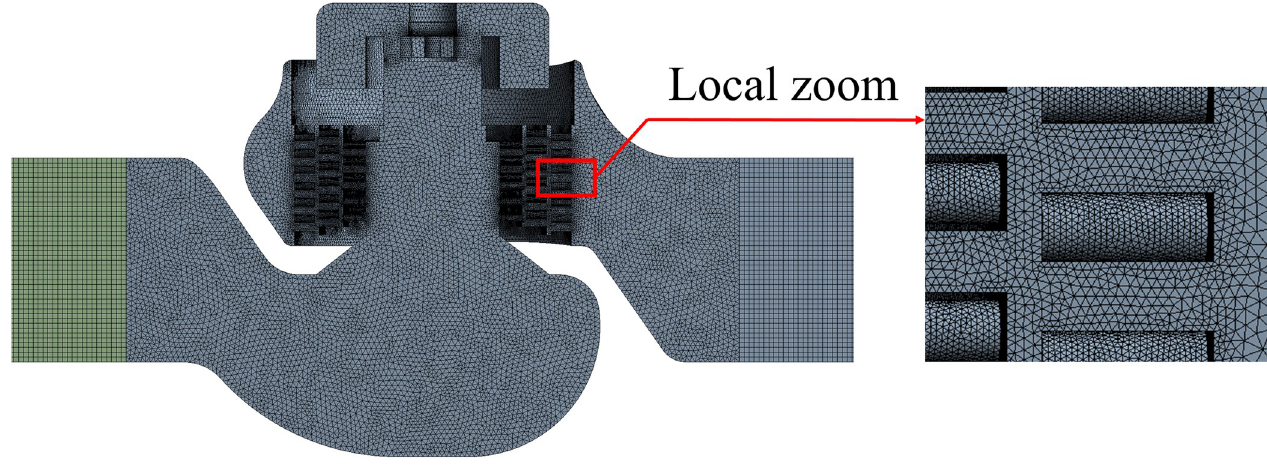
Fig 3. Fluid mesh model of the multistage pressure reducing